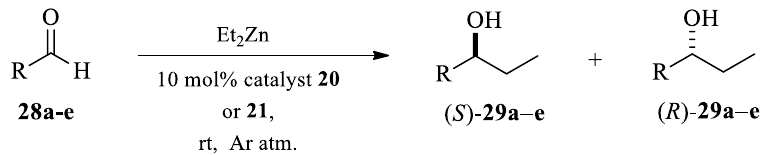
Scheme 8. Model reaction for enantioselective catalysis. Table 3. Addition of diethylzinc to aldehydes, catalyzed by 10 mol % 20 or 21.